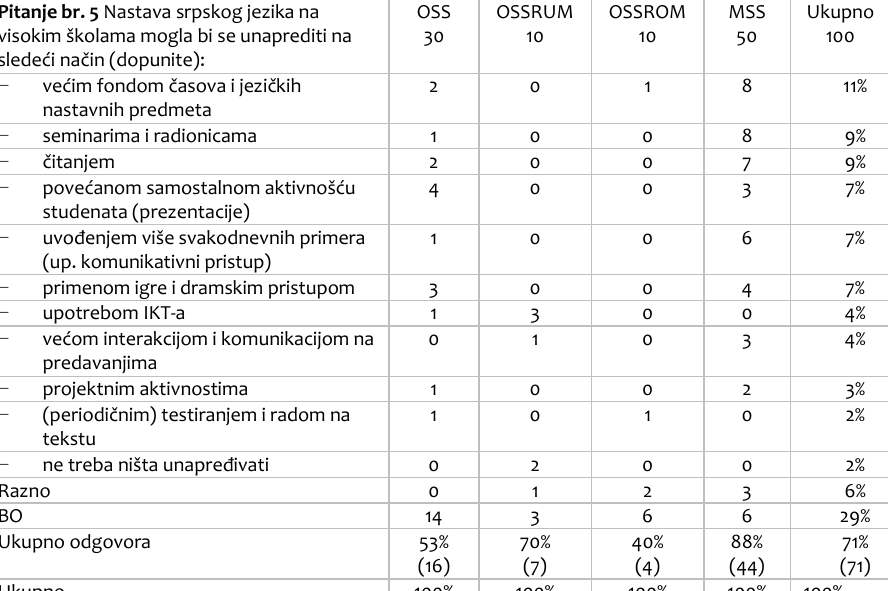
Tabela 7. Mogućnosti unapređivanja nastave srpskoga jezika iz perspektive studenata Pitanje br. 5 Nastava srpskog jezika na visokim školama mogla bi se unaprediti na sledeći način